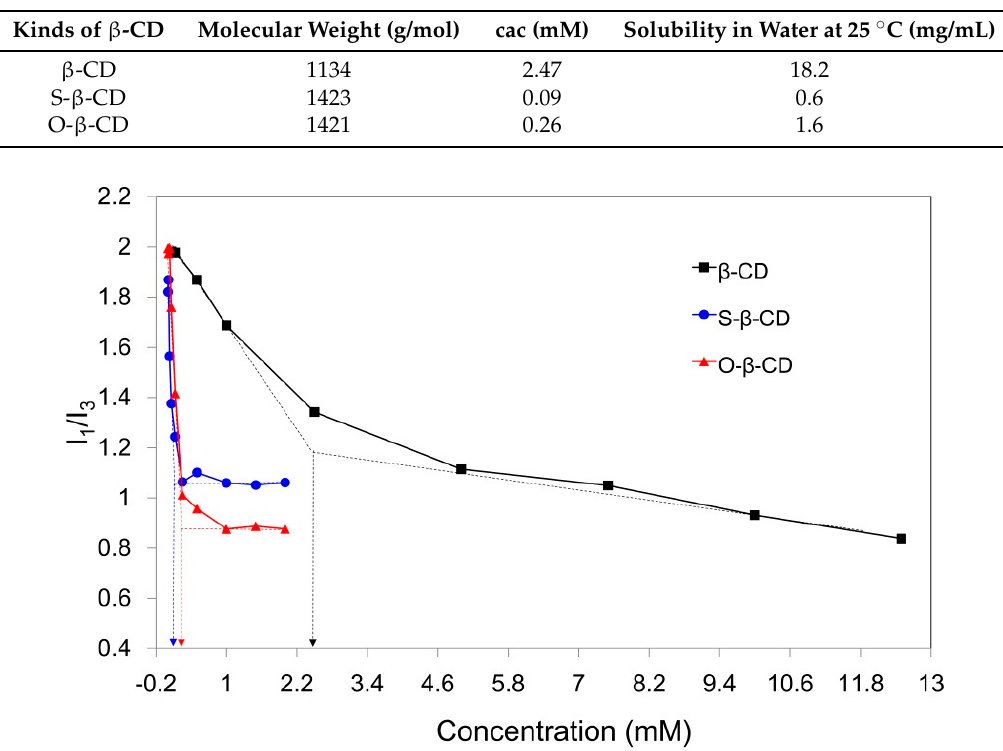
Figure 4. Relationship of pyrene fluorescence intensity ratios (I 1 /I 3 ) with the concentration of β -CD (black line), S- β -CD (blue line), and O- β -CD (red line). The arrows indicate the cac values of β -CD, S- β -CD, and O- β -CD.